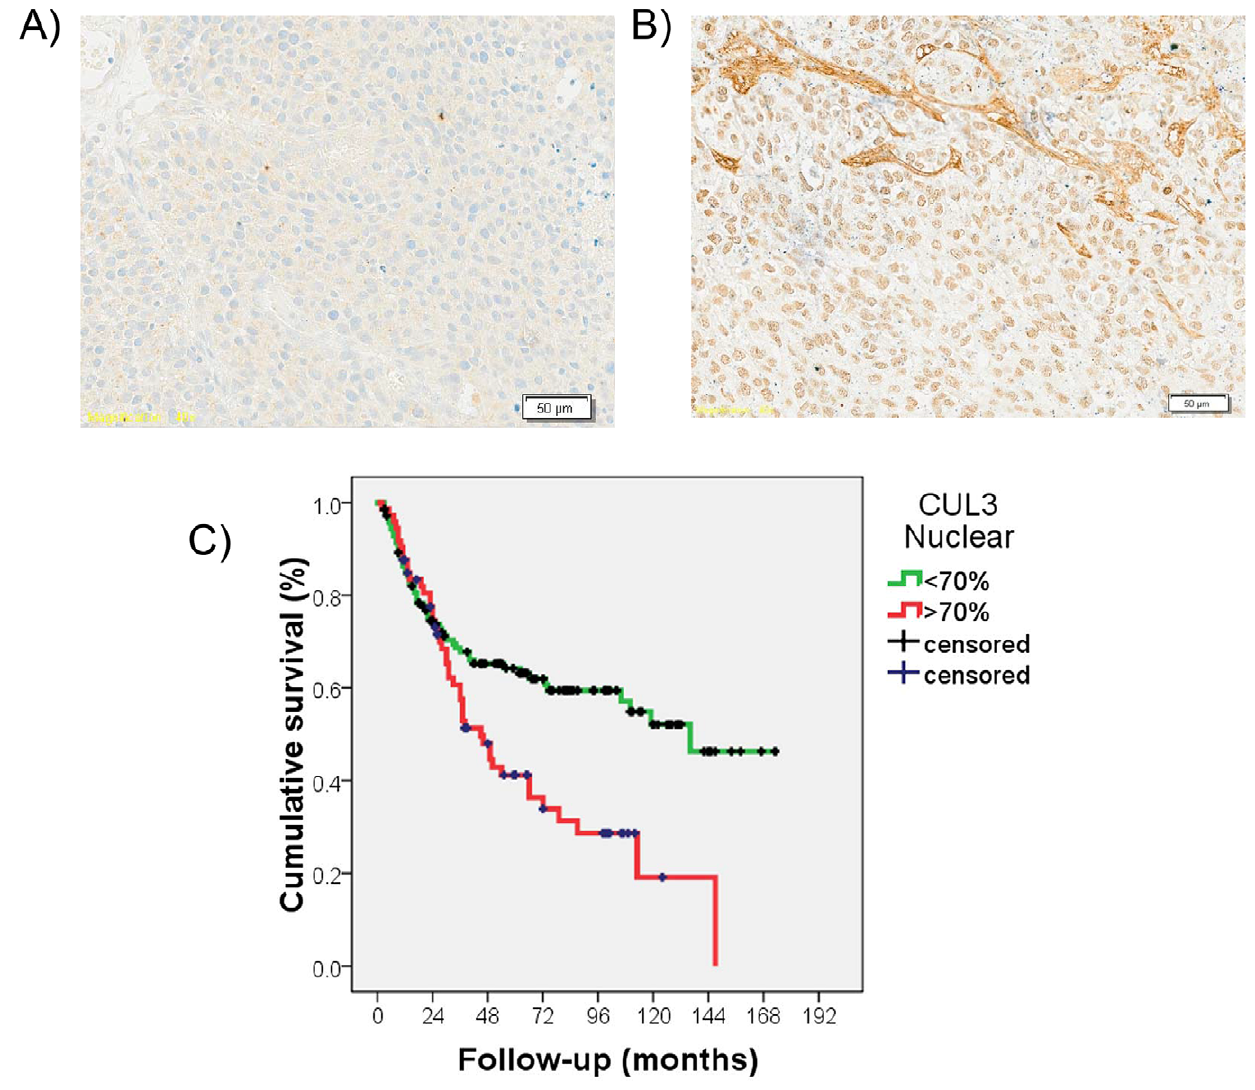
Figure 4. Clinical validation analyses of the differential expression of Cul3 in bladder cancer progression. ( A, B ) Representative immunohistochemistry expression patterns of Cul3 in non-invasive (A) and invasive (B) bladder tumors contained in tissue arrays. Strong expression of Cul3 was observed in invasive bladder tumors when compared to non-invasive lesions. Cul3 can also be observed in the extracellular matrix in B. There was a significant difference regarding the expression of Cul3 regarding tumor stage (p=0.001: Original magnifications: x200). ( C ) Kaplan-Meier curve survival analysis indicating that increased nuclear Cul3 protein expression assessed by immunohistochemistry in tissue arrays was significantly associated with poor disease-specific survival (p=0.002).